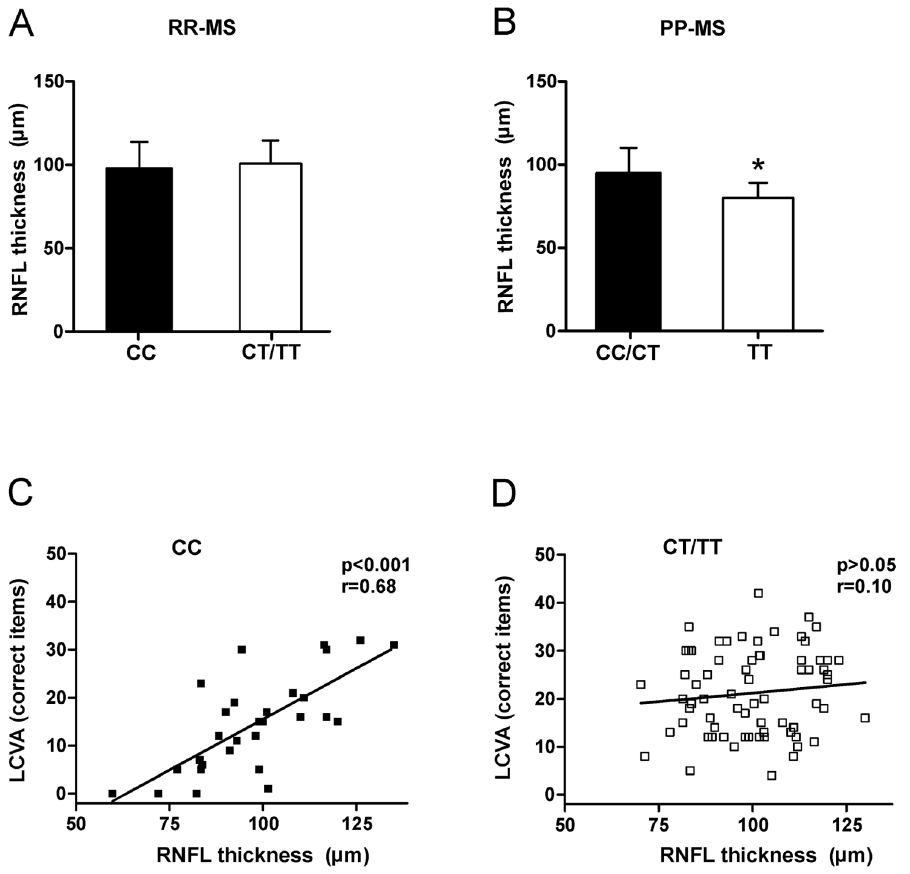
Figure 4. Effect of SNP rs4880213 on functional and morphological indexes of neuronal damage in MS. A. RNFL thickness was similar between CC and CT/TT RR-MS patients. B. RNFL thickness was lower among PP-MS subjects homozygous for T allele. C, D. Correlation analyses between RNFL thickness and LCVA in CC (C) and CT/TT (D) RR-MS patients. * means p , 0.05.